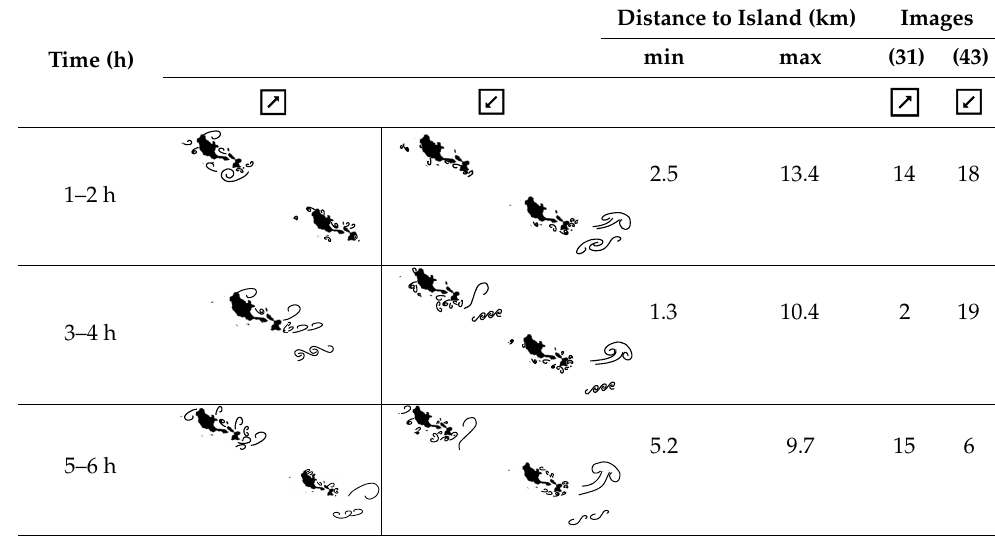
Table 4. Island wake in Tova Is. (black shaded areas). Time shows the time during which the tidal current had a consistent direction before image acquisition (in hours). Arrows indicate the predominant direction of the tidal current, disaggregated for each type of structure and direction. Distance between the center of Tova Is. and the farthest end of the structure is also indicated. Finally, the number of images where each structure is observed are included.